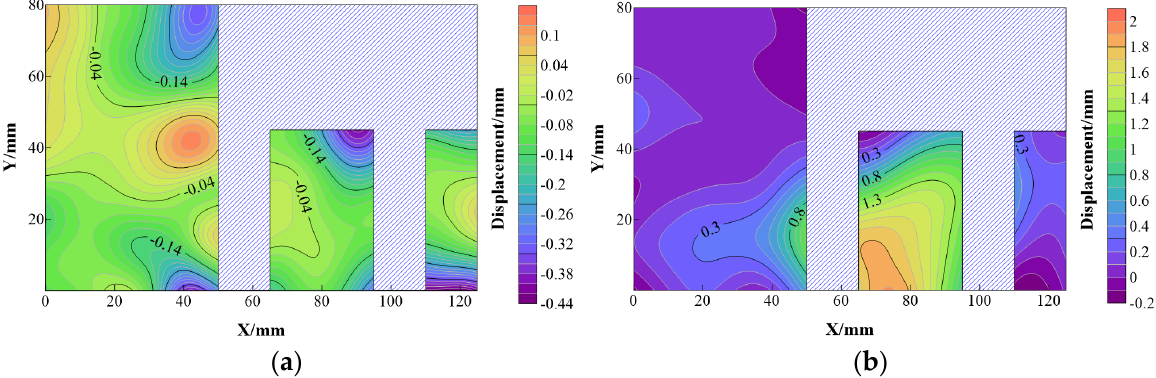
Figure 14. ( a ) X − direction contour diagram and ( b ) Y − direction contour diagram of soil displacement for MP − 15 model.